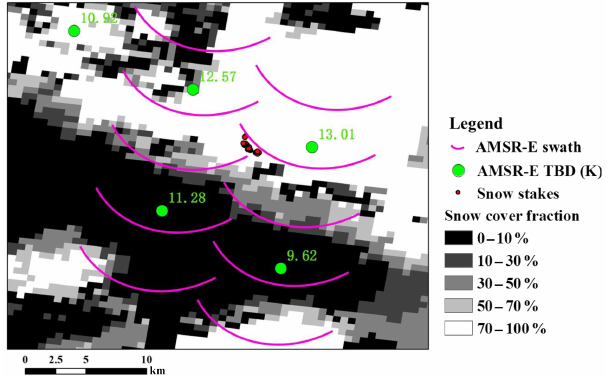
Figure 9. Distribution of snow cover fraction derived from MODIS products in the Binggou watershed, locations of snow stakes set dur- ing the Binggou watershed experiment, and the brightness temper- ature difference (TBD) between the 18 and 36GHz from